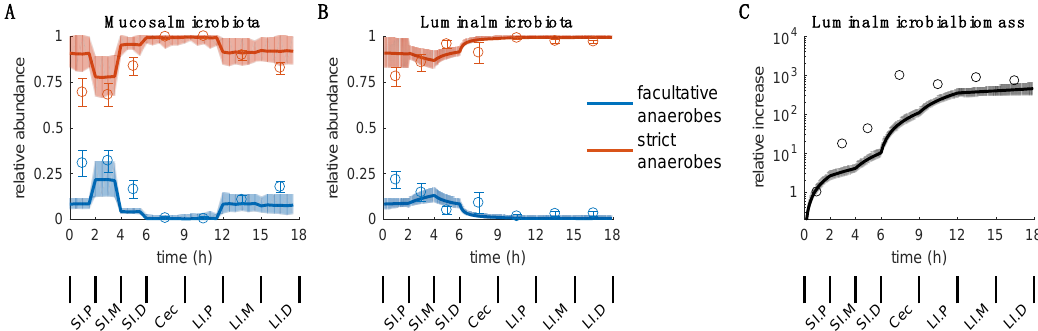
Figure 2. Simulated microbial abundance (lines) compared with experimentally determined microbial abundance (circles, from reference [24]) at various sections of the intestines in terms of facultative anaerobes vs obligate anaerobes. ( A ) Abundance profile for the mucosal microbiota. ( B ) Abundance profile for the luminal microbiota. ( C ) Relative increase in the luminal microbial biomass. The geometric mean of the luminal microbial biomass for all simulated time points in the first intestinal section (SI.P) was taken as the reference level. The shaded regions and the error bars in all plots represent one standard deviation. The markers at the bottom show the time intervals for which simulations of the corresponding intestinal sections were performed. SI.P, SI.M and SI.D stand for proximal, middle and distal small intestine respectively. Cec stands for cecum. LI.P, LI.M and LI.D stand for proximal, middle and distal large intestine, respectively.